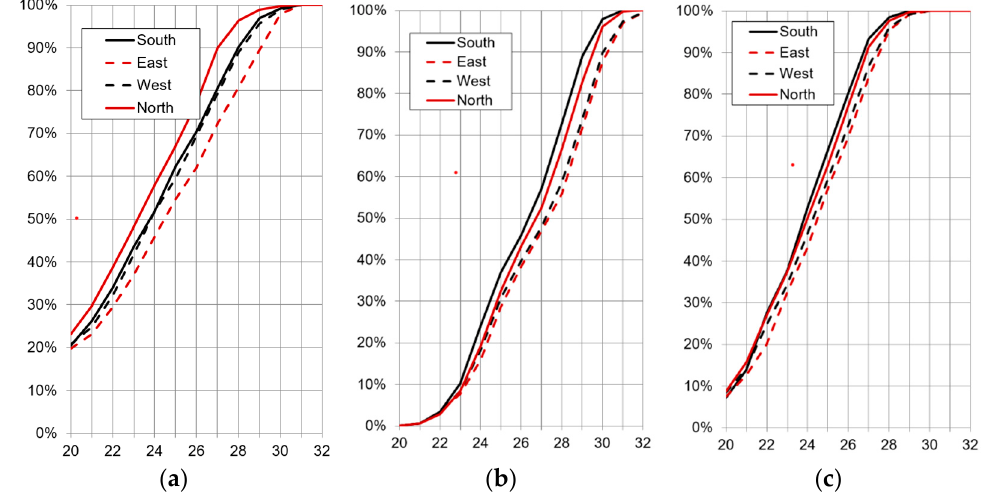
Figure 4. Cumulative distribution of the operative temperature in Milan for the following RB con- figurations: RB ( a ), NZEB + shad ( b ) and NZEB + shad + vent ( c ). configurations: RB ( a ), NZEB + shad ( b ) and NZEB + shad + vent ( c